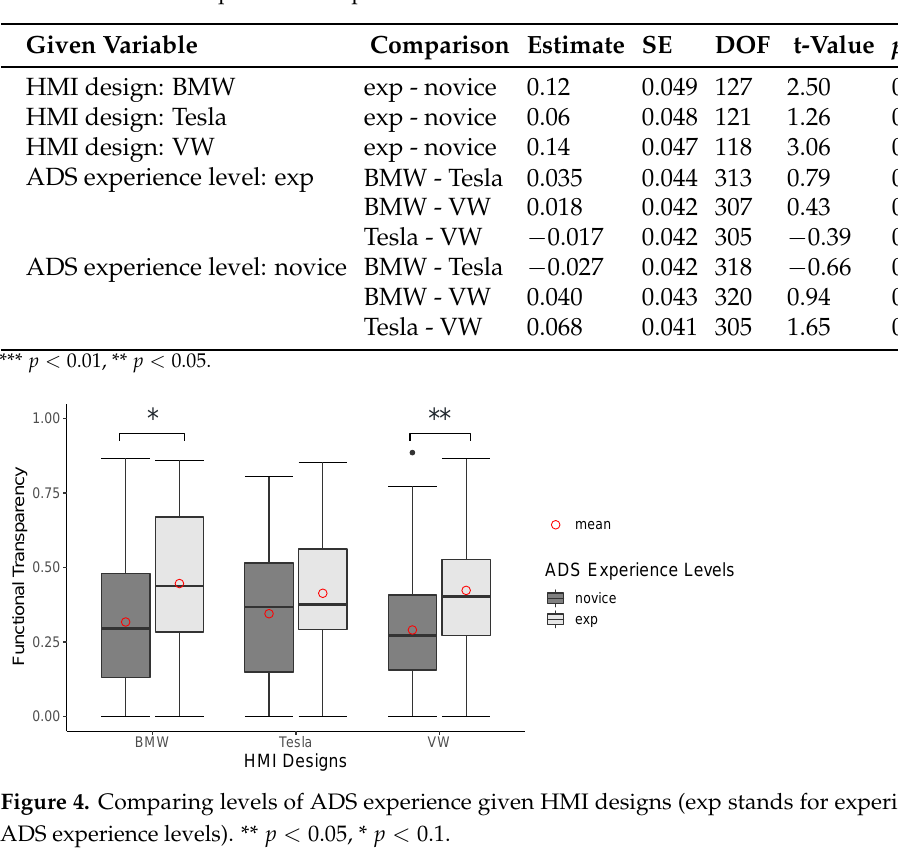
Table 4. Results of all pairwise comparisons.